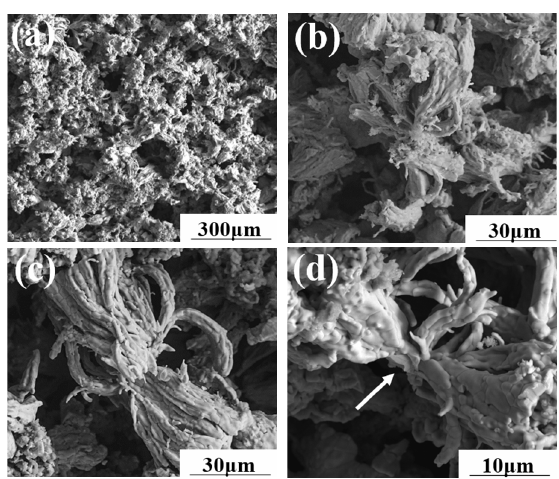
Fig. 5 SEM images of Ti 2 PbC powders synthesized from Ti/Pb/TiC after synthesis at 1370 ℃ at 2 /min ℃ for 2 h (sample D): (a) the as-prepared Ti 2 PbC powders, (b) the flower-like Ti 2 PbC, (c) the bowknot-like Ti 2 PbC, and (d) higher magnification images of the bowknot.